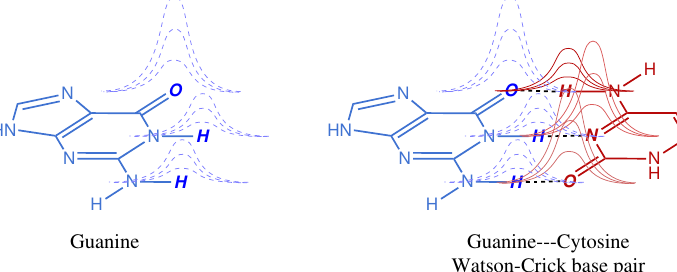
Figure 1. Schematic representation of the basis set superposition error (BSSE) in a single Watson–Crick base pair. Atom centered Gaussian functions are represented with like colors, atoms whose electron density is partially described by Gaussian tails of functions centered in atoms belonging to the other monomer are indicated in boldface and slanted